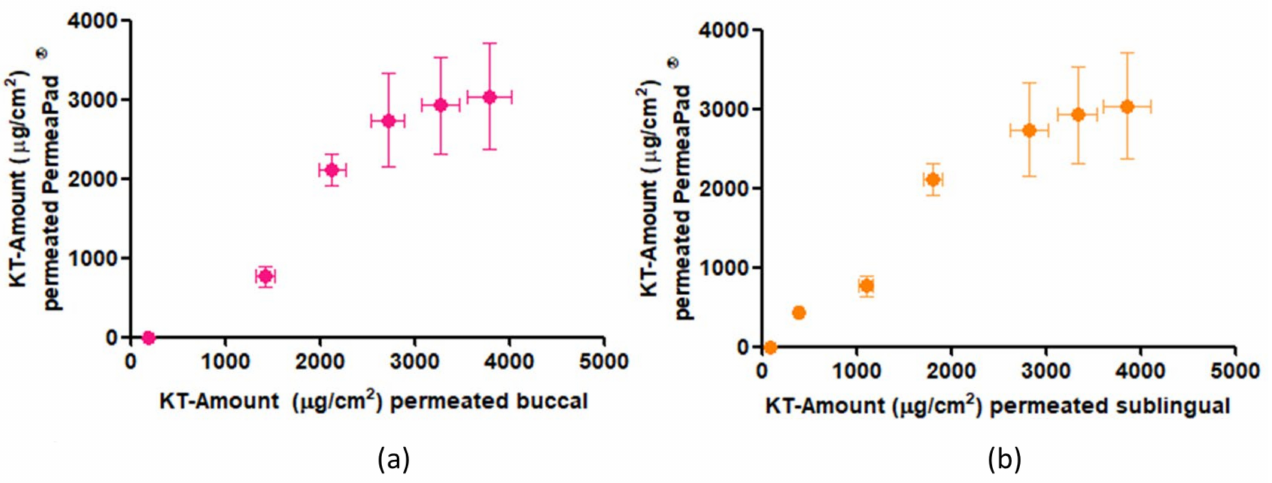
Figure 4. In vitro–ex vivo correlation: ( a ) correlation of in vitro permeation through PermeaPad ® membrane and ex vivo permeation through buccal mucosa, ( b ) correlation of in vitro permeation through the PermeaPad ® membrane and ex vivo permeation through sublingual